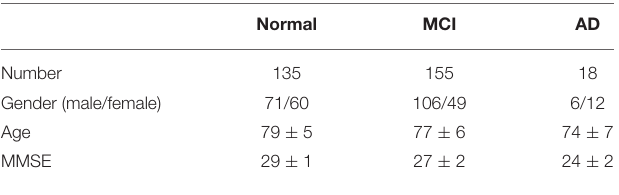
TABLE 1 | Demographic information of